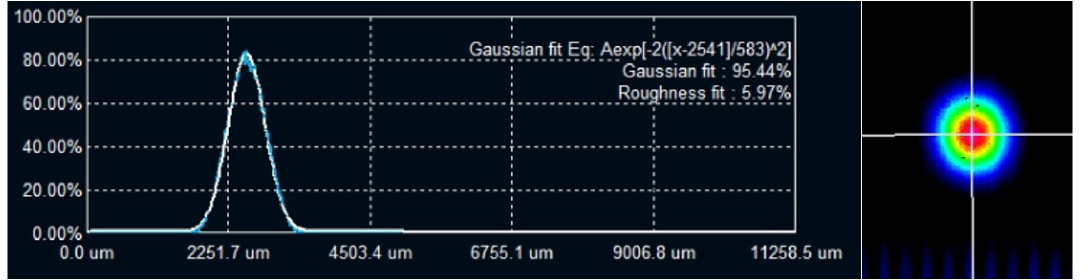
Figure 9. Results of the laser beam shape measurement 30 cm away from the laser cavity. Assembled lasers could achieve a 95.44% Gaussian